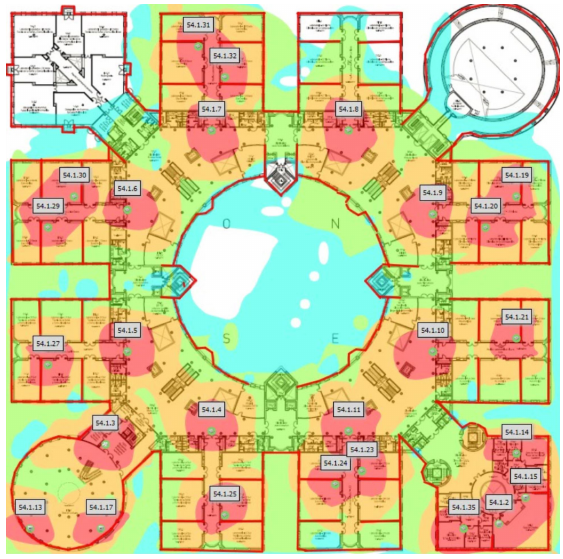
Figure 4. Polytechnic school building